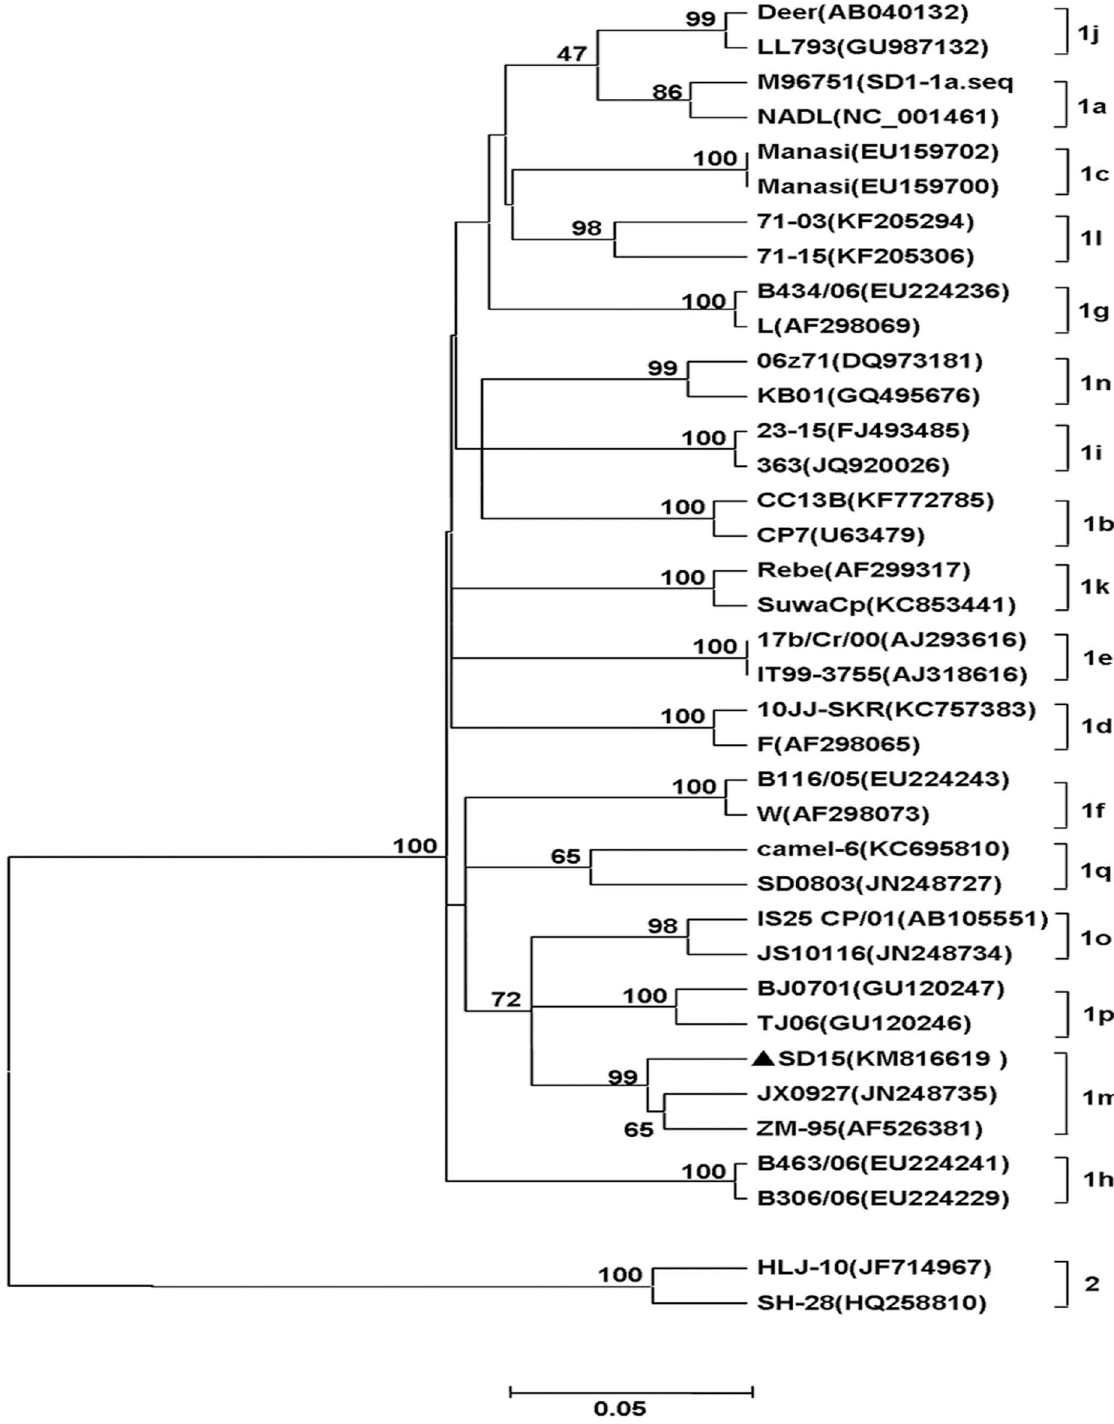
Fig 2. Phylogenetic analysis of SD-15 isolates based on 5’-UTR sequences. Phylogenicrelationship of SD-15 to pestiviruseswas generated by analyzingthe 5’-UTR sequencesfrom 36 representative BVDV isolates using neighbor-joining method. SD-15, together with BVDV ZM-95 and JX0927 was clustered to BVDV-1m subgenotype and marked as solid triangle.